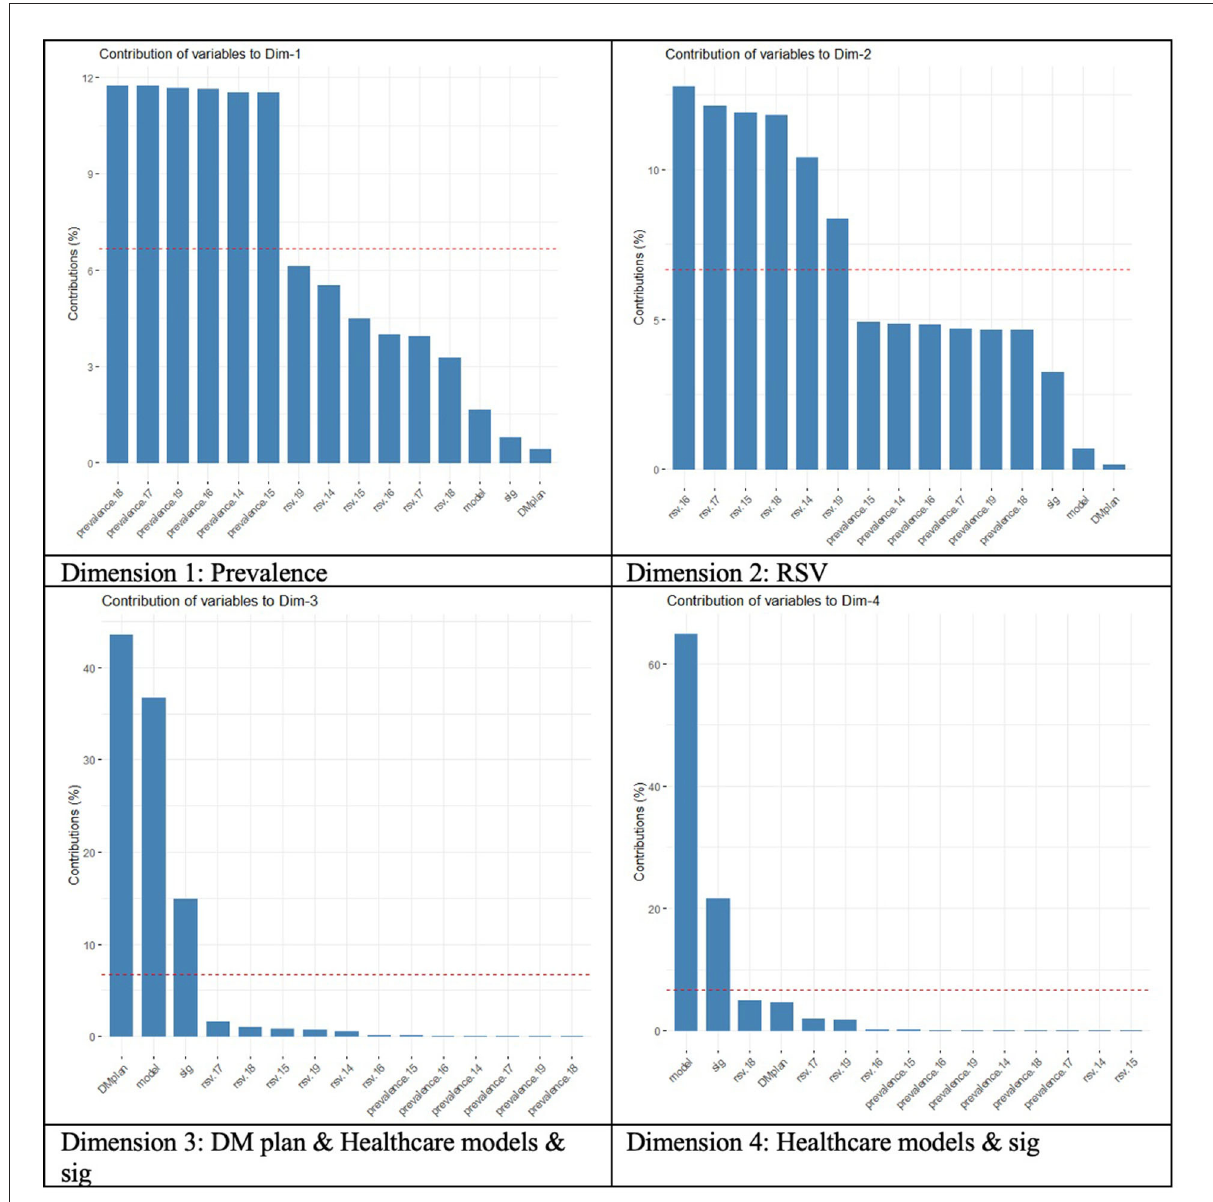
FIGURE3 Contribution of variables to the principal dimensions (“Prevalence,” “RSV diabetes,” “DM day,” “DM plan, Healthcare models & Sig” and “Healthcare models & Sig”).